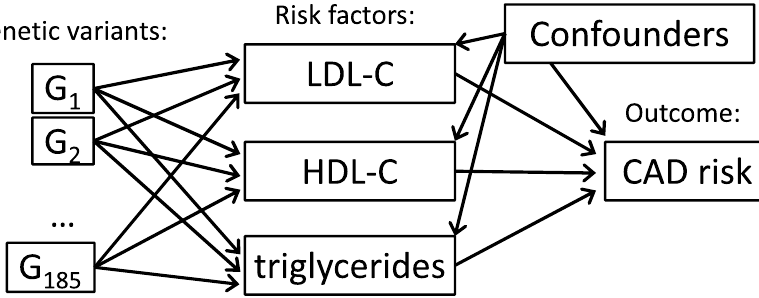
Figure 3. Causal assumptions as a directed acyclic graph. Diagram of causal relationships between genetic variants, risk factors (low-density lipoprotein cholesterol, LDL-c; high-density lipoprotein cholesterol, HDL-c; and triglycerides), confounders, and disease (coronary artery disease, CAD). Although confounders (common causes of a risk factor and the outcome) are represented as a single variable for simplicity, each risk factor may have a different set of confounders. doi:10.1371/journal.pone.0108891.g003 90th percentiles (0.94, 0.86 to 1.02, P =0.13). The post hoc results